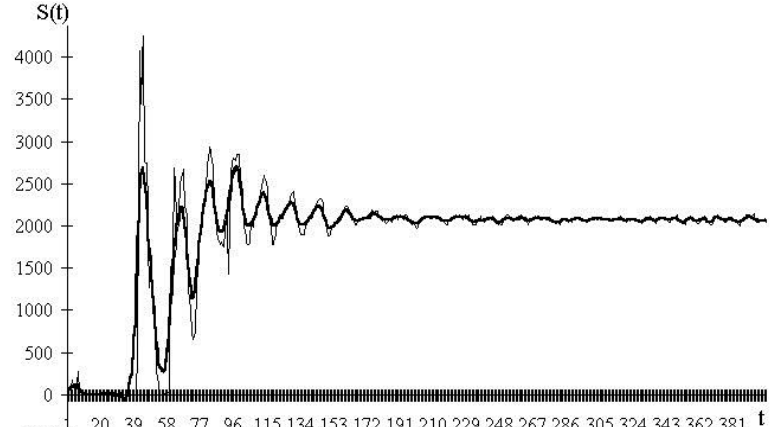
Fig. 11. Transient measurement processing results with a minimum covering length of 20.